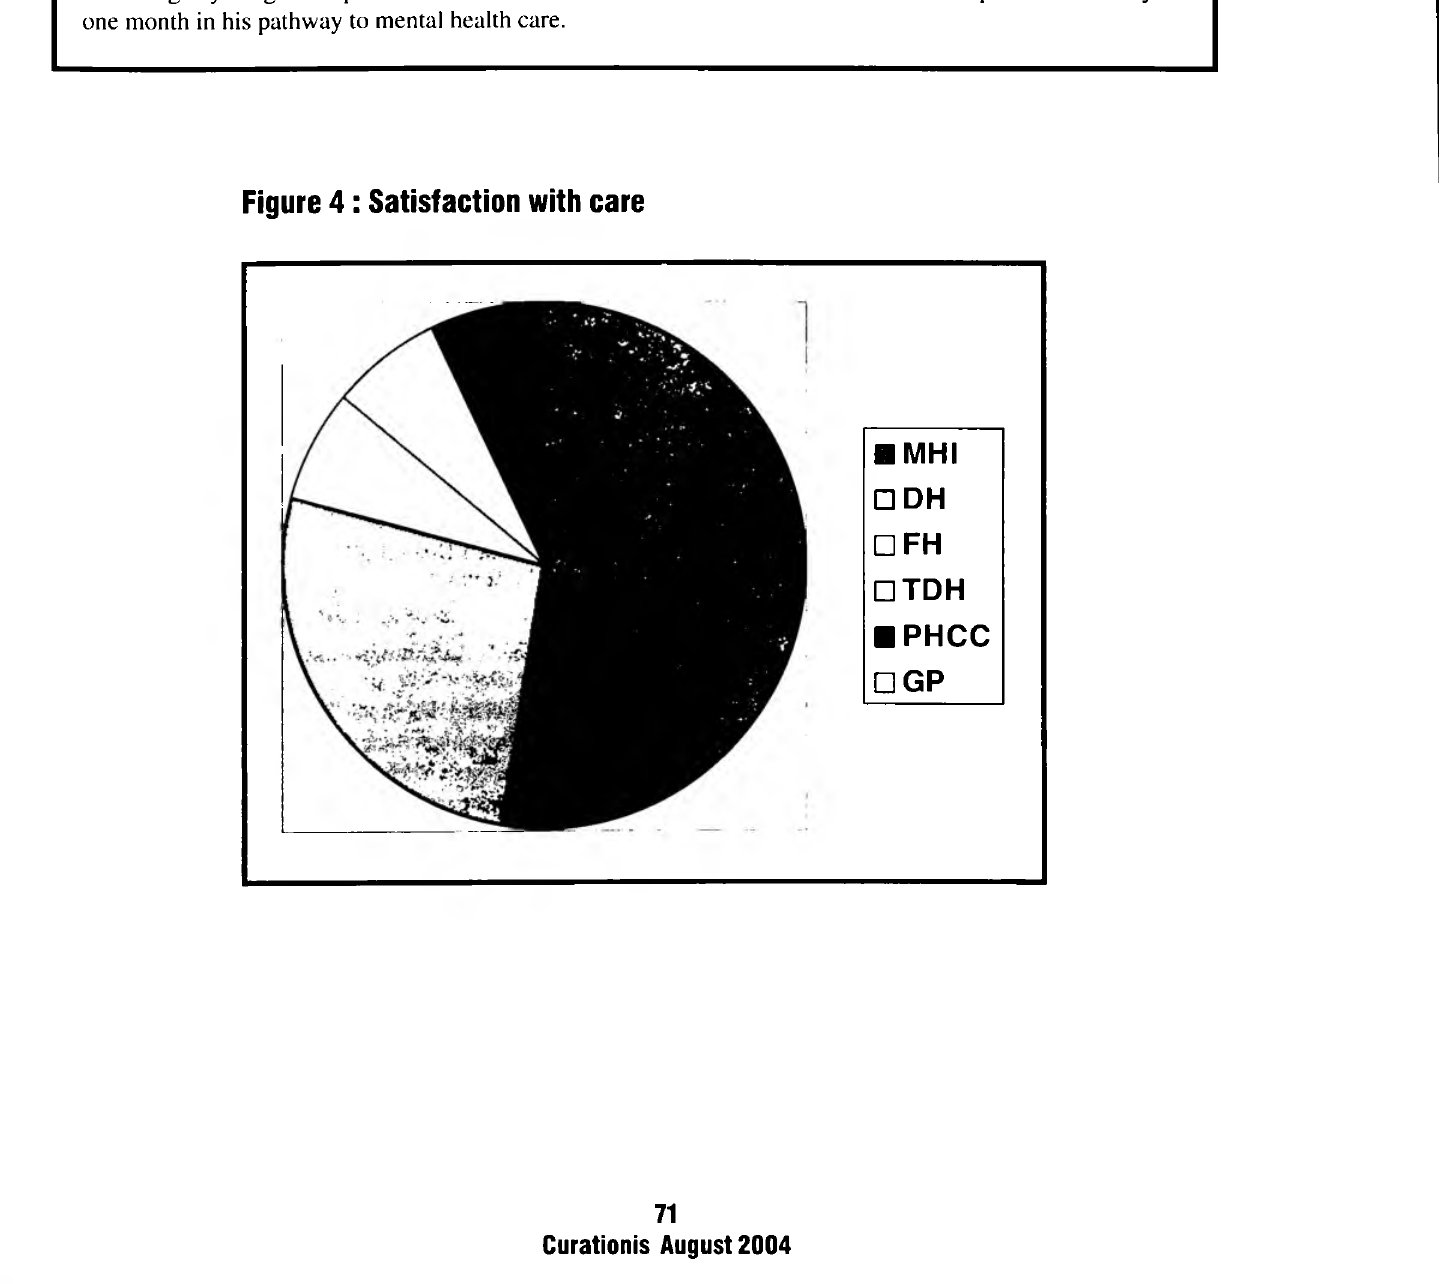
Figure 4 : Satisfaction with